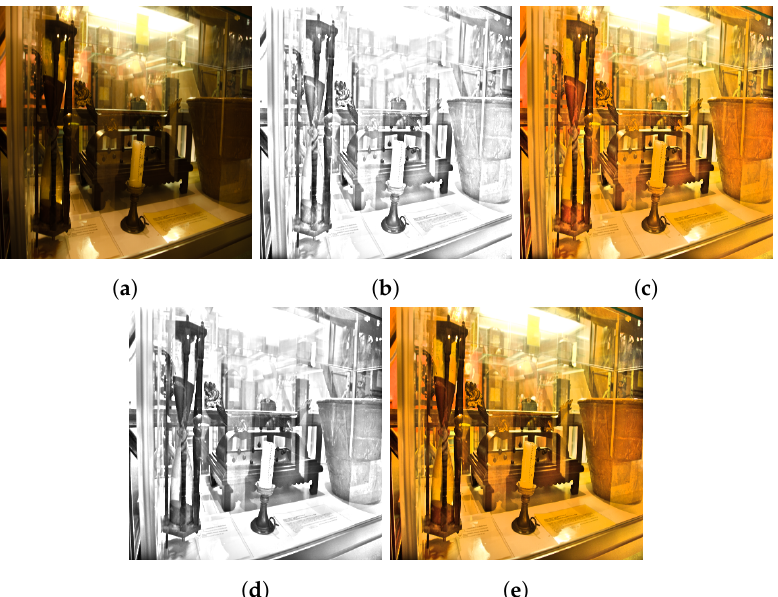
Figure 7. Comparison of SVD-CSC and CSC methods without SVD: ( a ) Original test image; ( b ) Reflectance using CSC general dictionary; ( c ) Image enhancement using CSC general dictionary; ( d ) Reflectance using SVD-CSC general dictionary; ( e ) Image enhancement using SVD-CSC general dictionary.